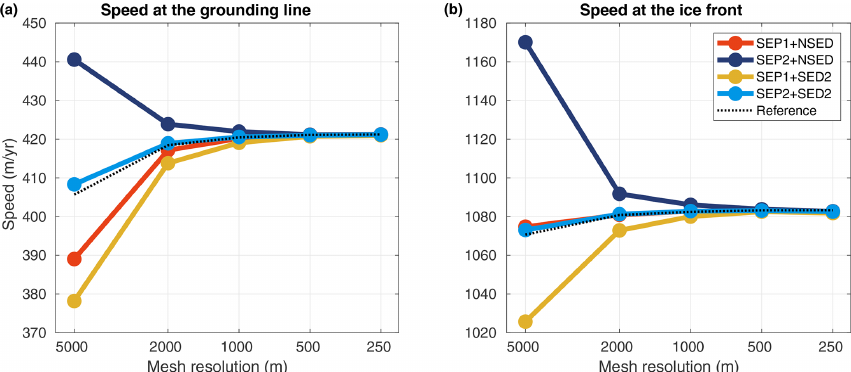
Figure 2. Convergence of the ice speed at the grounding line ( x = 600km, a ) and at the ice front ( x = 800km, b ) obtained in the diagnostic analysis. All sets of sub-element parameterizations are shown: SEP1 + NSED, SEP2 + NSED, SEP1 + SED2, and SEP2 + SED2. Reference speeds from structured conforming-mesh-based models are also displayed (reference, dotted